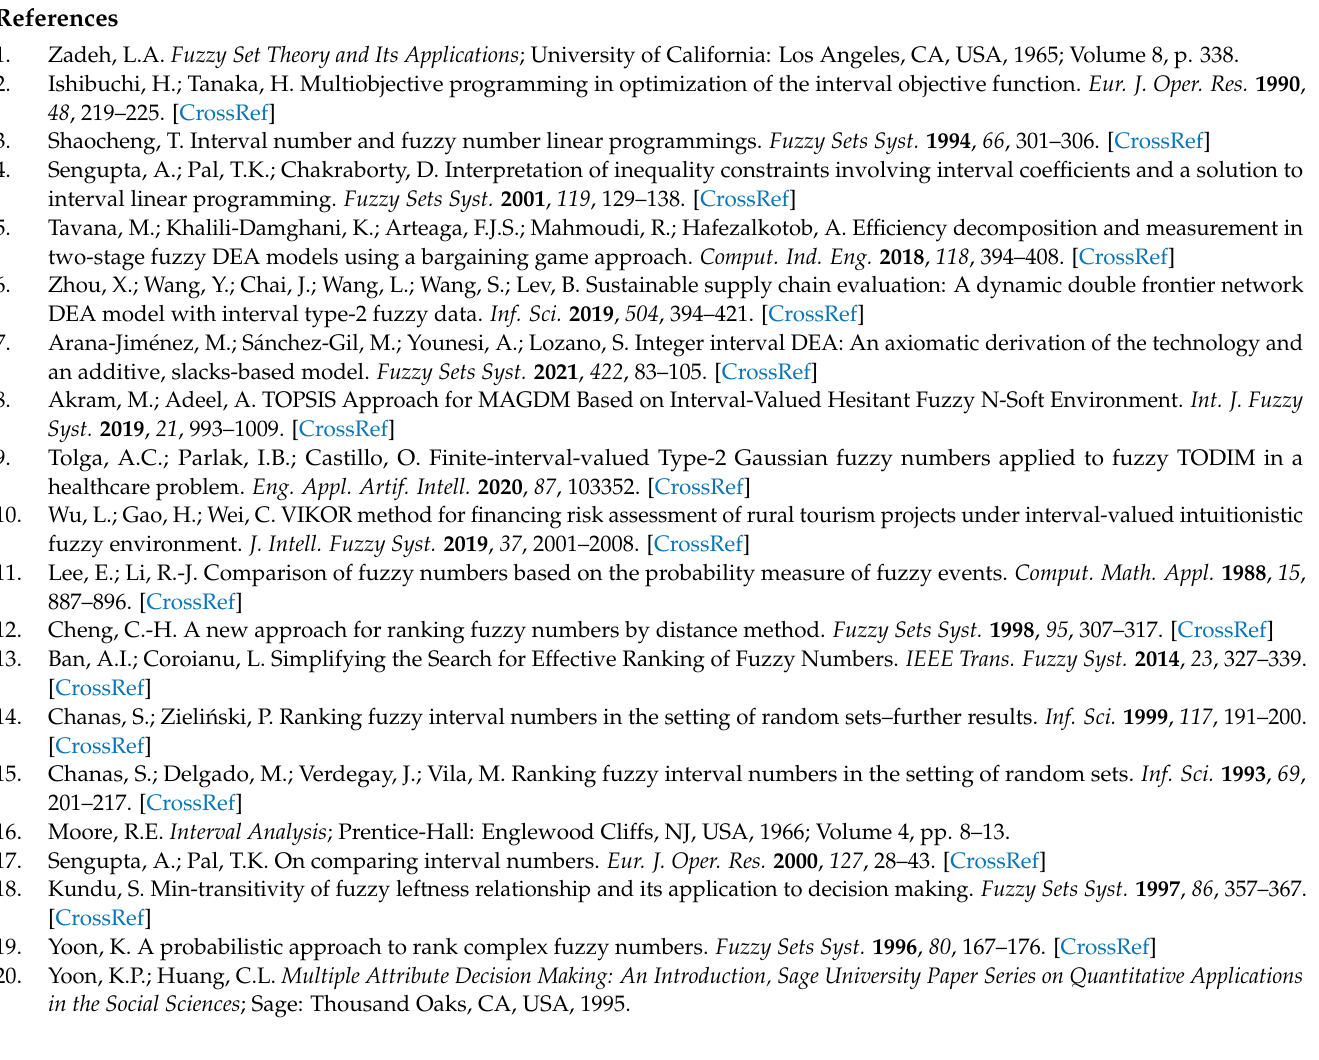
Figure A2. The trade-off result where u ( A 1 ) ≈ u ( A 2 )